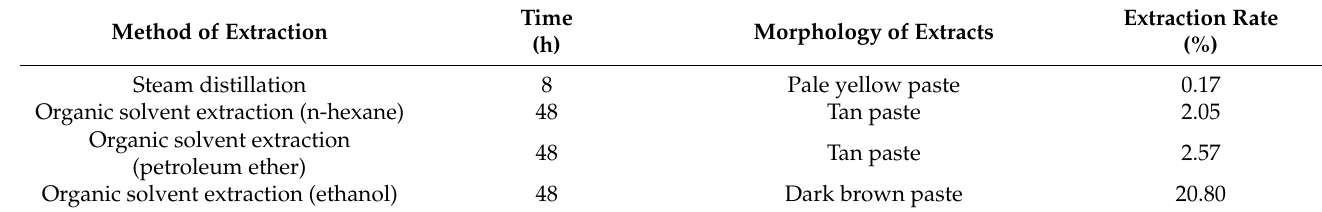
Table 1. Results of different extraction methods for saffron